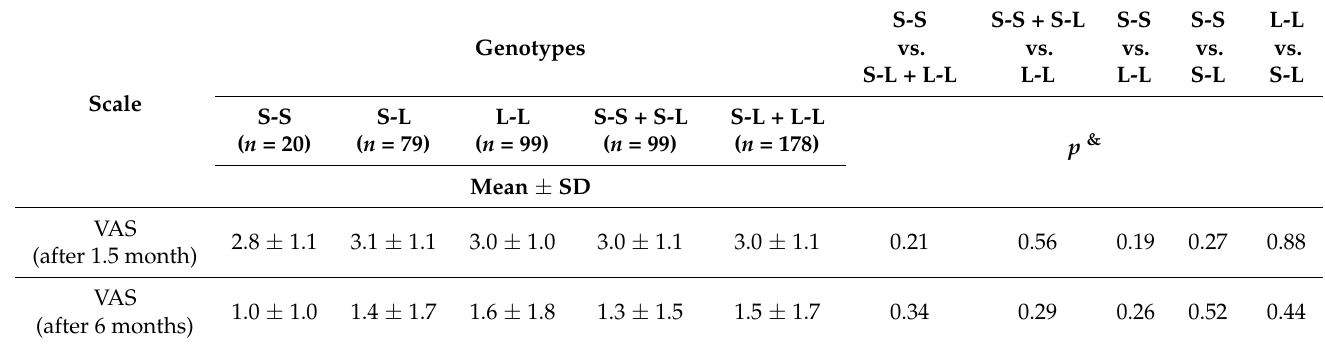
Table 6. Association of CNR1 genotype with pain intensity in patients at defined intervals.